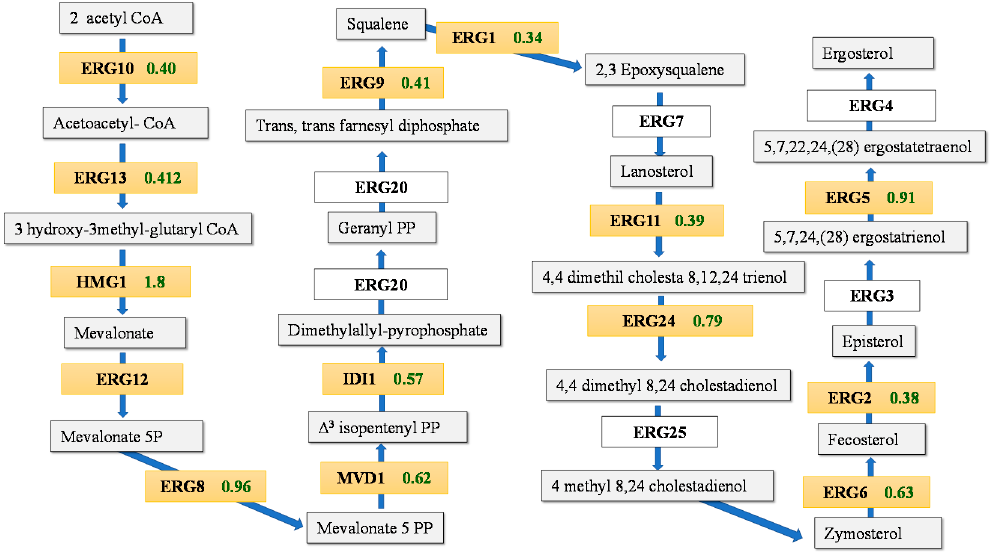
Figure 3. Ergosterol biosynthetic pathway. ORFs showing significant upregulation in SJ with respect to FSJ in EC1118 and M25 are highlighted in yellow. Green numbers indicate mean log2 ratio (SJ/FSJ). Table 3. Transcription factors associated with upregulated and downregulated ORFs in SJ with respect to FSJ.